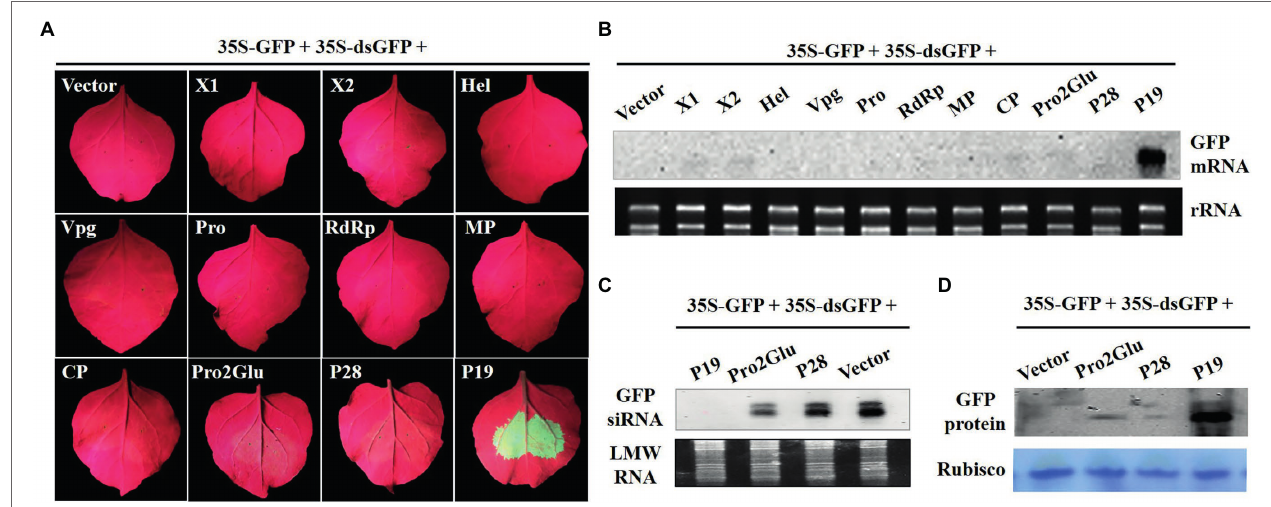
FIGURE 2 | Pro2Glu and P28 failed to suppress local silencing triggered by dsGFP. (A) The observation of GFP fluorescence in wild-type N. benthamiana leaves co-infiltrated by 35S-GFP, 35S-dsGFP, and pCHF3 vectors expressing individual proteins of SMoV at 3 dpi. The plants co-infiltrated by 35S-GFP, 35S-dsGFP, and pCHF3 empty vector or pCHF3-P19 were designated as negative or positive controls, respectively. (B) The analysis of GFP mRNA in infiltrated leaf patches by Northern blot at 3 dpi. (C) Northern blot analysis of GFP-specific siRNA in infiltrated leaf regions at 3 dpi. (D) Western blot analysis of GFP protein in infiltrated leaf regions at 3 dpi using anti-GFP monoclonal